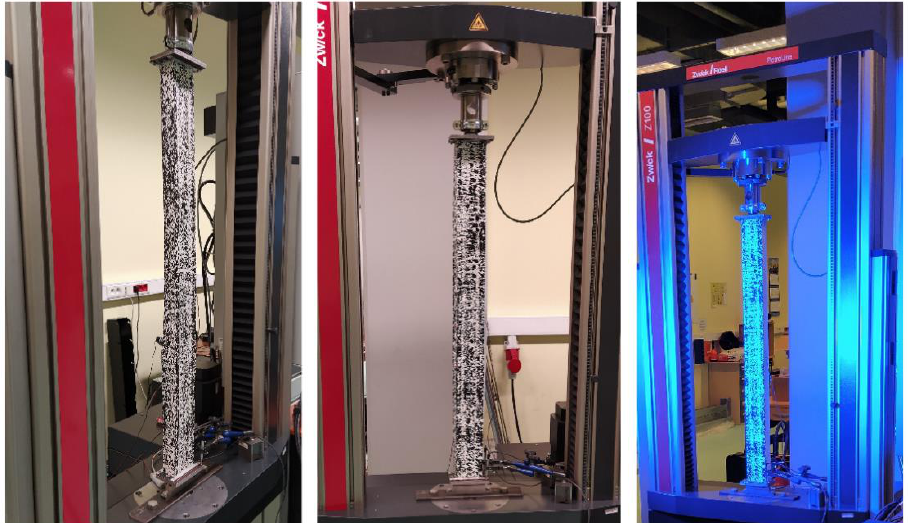
Figure 3. Test columns mounted in the testing machine.